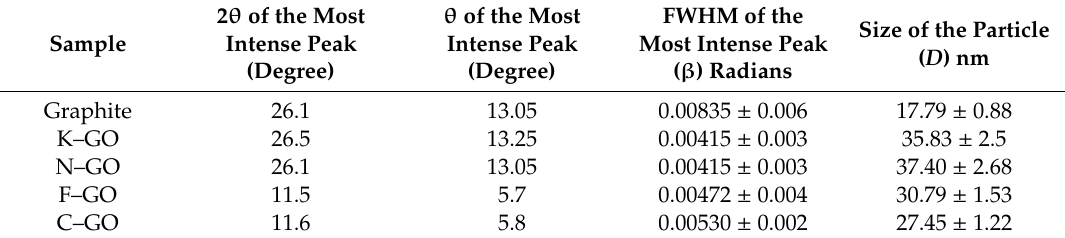
Table 1. Average grain sizes of graphene oxide nanosheets (GO NS).